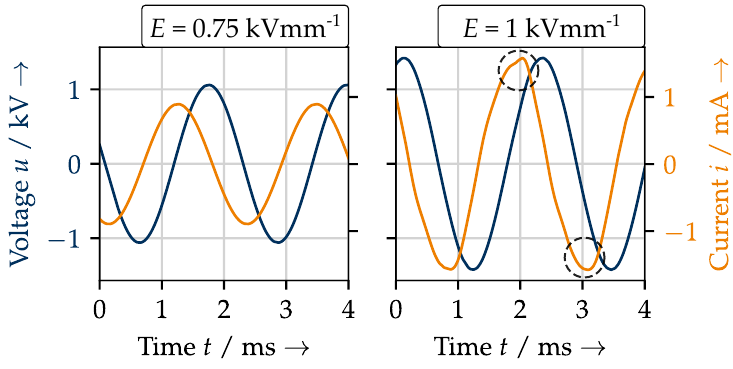
Figure 8. Measured voltage and current at E = 0.75kVmm − 1 and 1kVmm − 1 (450Hz); highlighted current waveform distortion in the positive and negative half-wave.